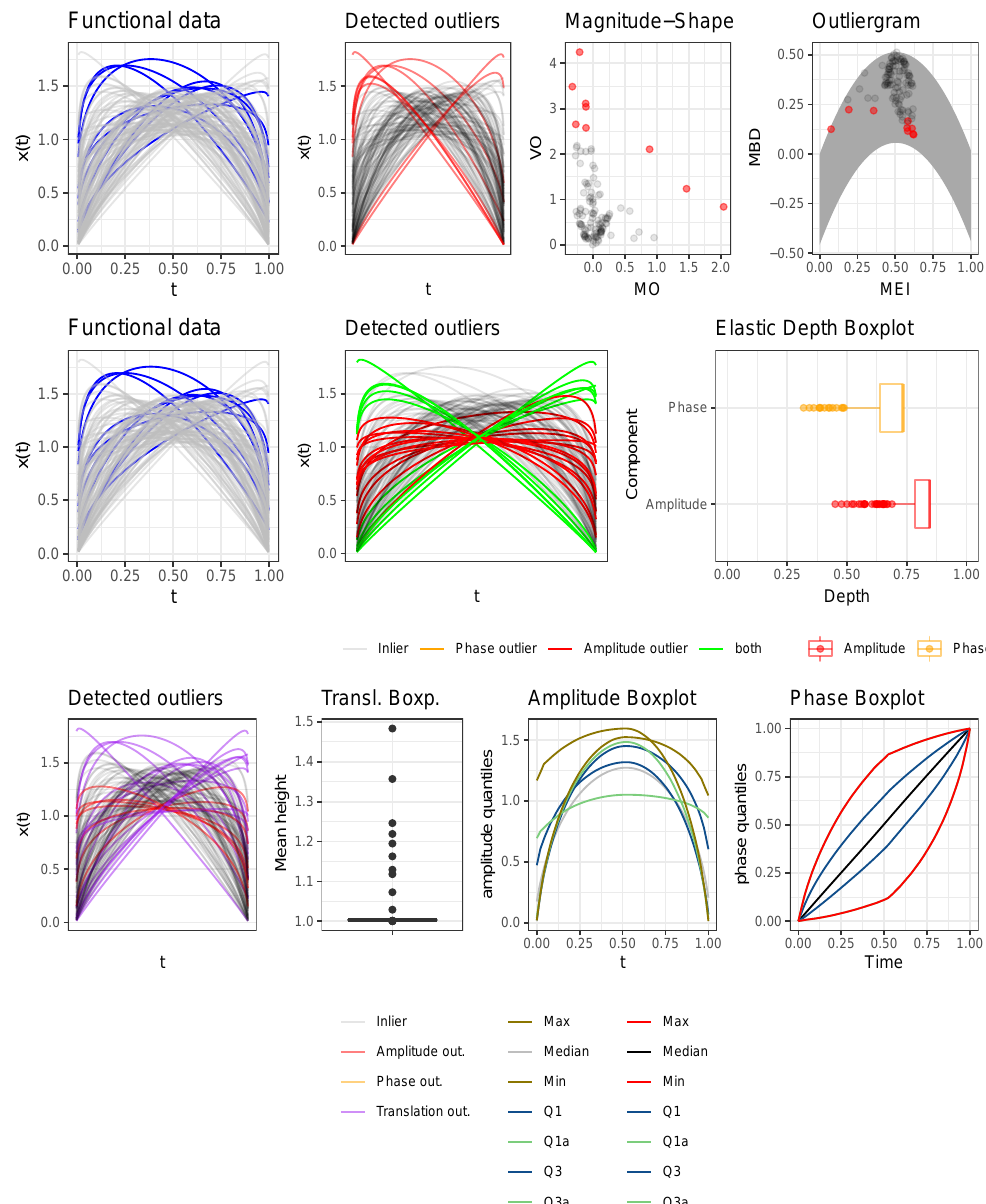
Figure A4. First column of first two rows: data with true outliers in blue; subsequent columns: data with detected outliers in color. First row: magnitude–shape plot of mean directional outlyingness (MO) versus variability of directional outlyingness (VO) and outliergram of the modified epigraph index (MEI) versus modified band depth (MBD) with the inlier region in grey. Second row: Elastic depth boxplots. Third row: translation–phase–amplitude boxplots. For the results of the HDR boxplots on the data, see Figure